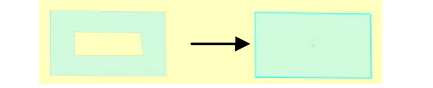
Figure 8. Fill Hole tool result. Source: ArcGIS Desktop 9.3 Web